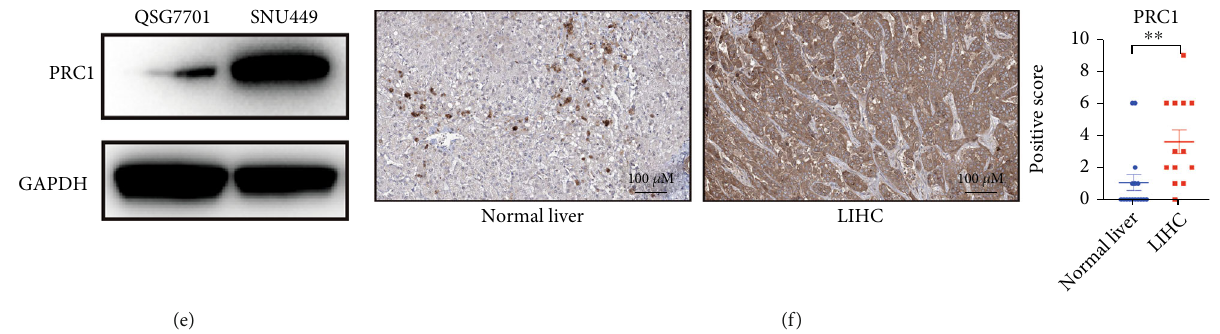
Figure 2: The expression of PRC1 was elevated in LIHC. (a) The pan-cancer analysis of PRC1 expression. (b) The volcano map of di ff erentially expressed genes (DEGs) between LIHC and normal liver, obtained from four GEO datasets: GSE60502, GSE84402, GSE84598, and GSE112790. PRC1 was noted. (c) The intersection of the DEGs from four GEO datasets. (d) The mRNA level of PRC1 in QSG7701 and SNU449 cells. (e) The protein level of PRC1 in QSG7701 and SNU449 cells. (f) The IHC results of PRC1 in LIHC and normal liver tissues from the HPA database. The scored results were as shown in the right panel. ns, p ≥ 0 : 05 ; ∗ p < 0 : 05 ; ∗∗ p < 0 : 01 ; ∗∗∗ p < 0 : 001